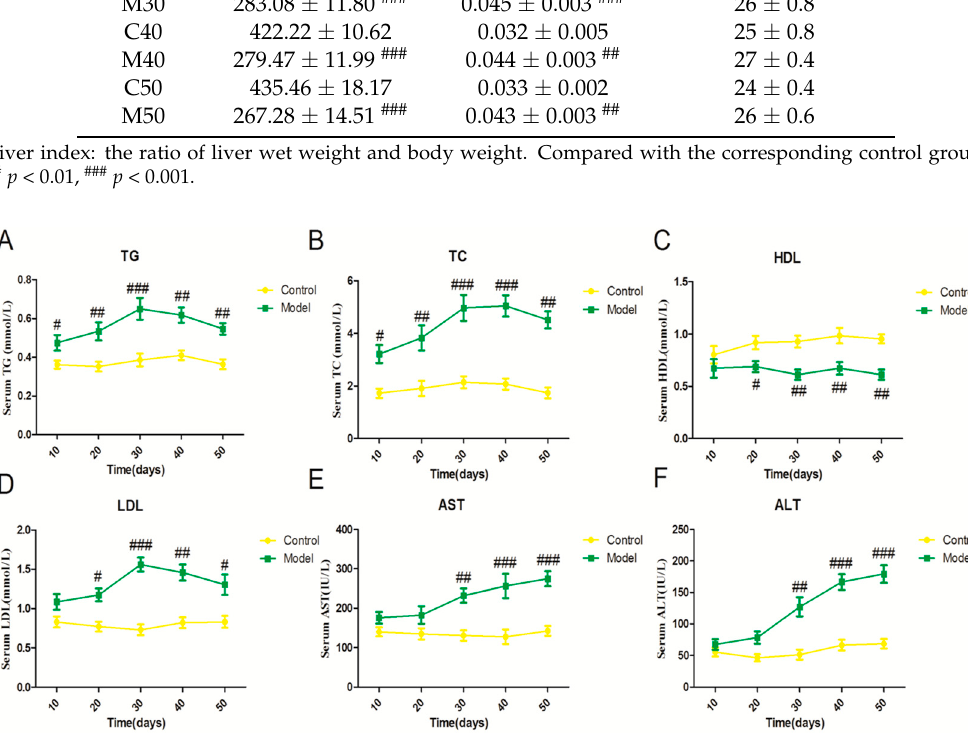
Figure 1. Effect of a high fat-sucrose diet on serum lipid profiles and liver function indicators. The serum lipid parameters of sprague-dawley (SD) rats induced by a high fat-sucrose diet on day 10, 20, 30, 40, 50. ( A ) Total triglyceride (TG); ( B ) Total cholesterol (TC); ( C ) High-density lipoprotein (HDL); ( D ) Low-density lipoprotein (LDL); ( E ) Aspartate aminotransferase (AST); ( F ) Alanine aminotransferase (ALT). The values are shown as the means ± standard error of mean (SEM) ( n = 6). Compared with the corresponding control group, # p ＜ 0.05, ## p < 0.01, ### p < 0.001.